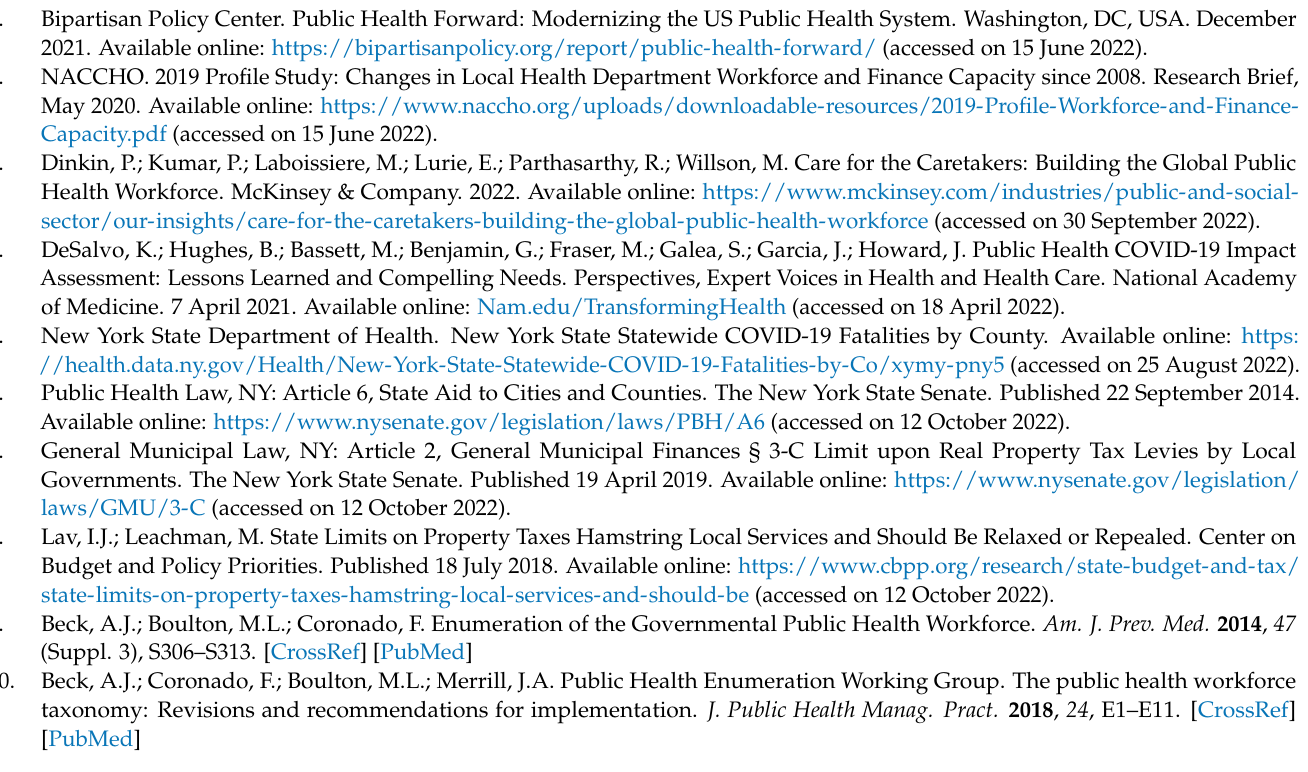
Figure A4. Sensitivity Analysis for Figure 3.